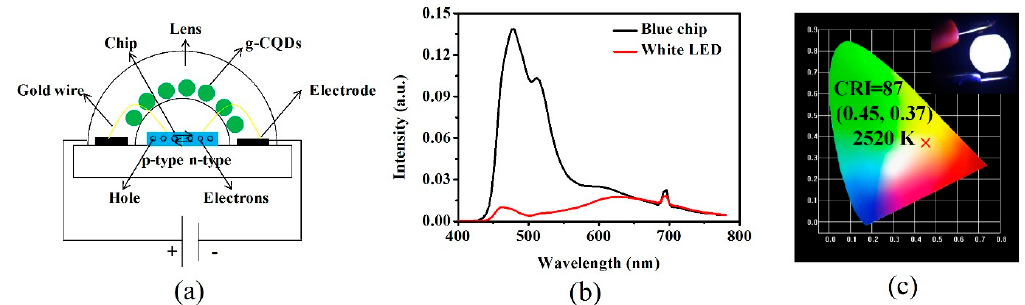
Figure 9. Schematic diagram of ( a ) the structure of white LEDs based on g-CQDs (V (EDA) = 4 mL, T = 180 °C, D r = 12 h); ( b ) emission spectrum of the single blue light chip and white LEDs; ( c ) CIE chromaticity diagram of white LEDs, inset is the photo of white LEDs.